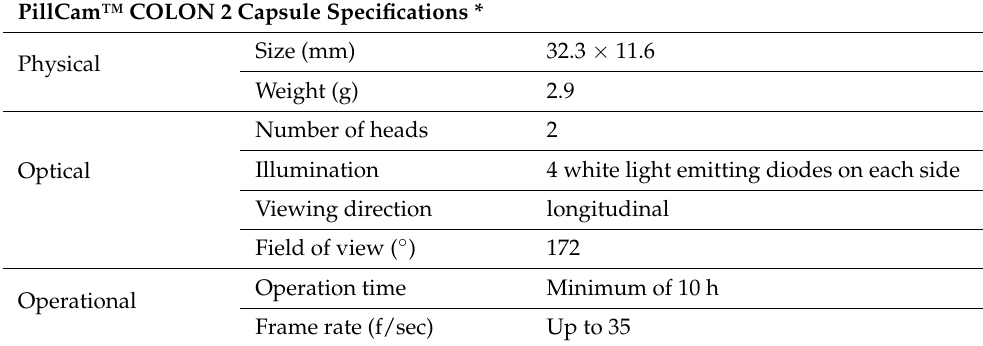
Table 1. Technical characteristics of 2nd-generation colon capsule.